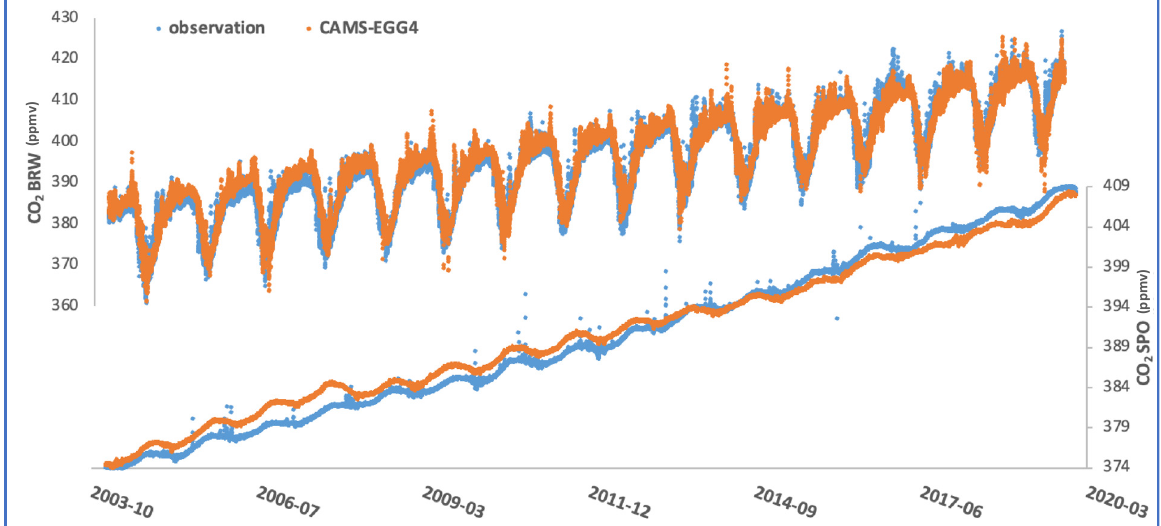
Figure 4. CO 2 time series at Barrow ( top ) and South Pole ( bottom ) obtained from ground-based observa-tion and CAMS re-analysis. Both datasets are presented at a time resolution of 3 h.